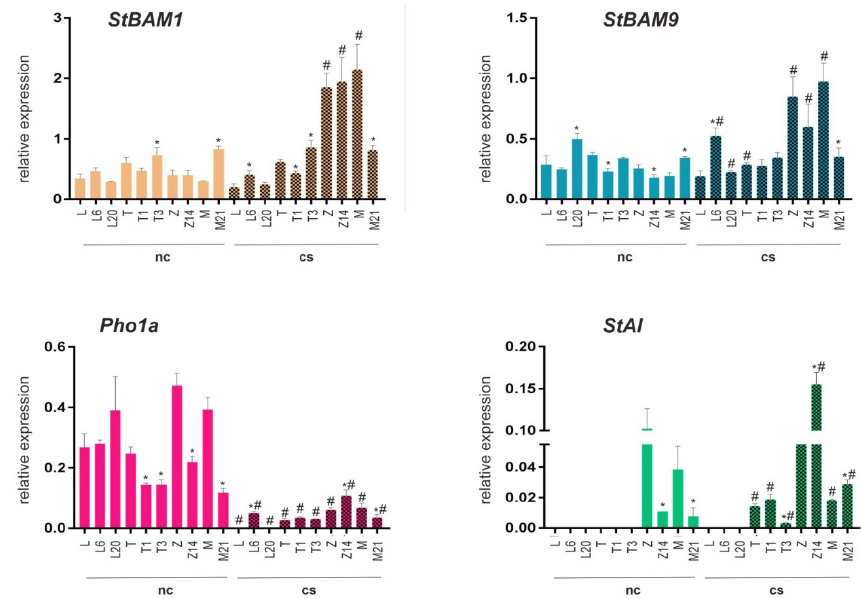
Figure 3. Expression of the StBAM1 , StBAM9 , PHO1a , and StAI genes in the leaves of potato cultivars Lux (L), Terra (T), Zhukovskii rannii (Z), and Mishka (M) and the indicated transgenic lines at normal growth conditions (+21 °C; nc) and in response to cold stress (+4 °C for 3 days; cs). The data were normalized to ELF1 and SEC3A mRNA levels and presented as the mean ± SD ( n = 3); * p < 0.01—transgenic vs. wild-type plants; # p < 0.01—cold stress vs. normal